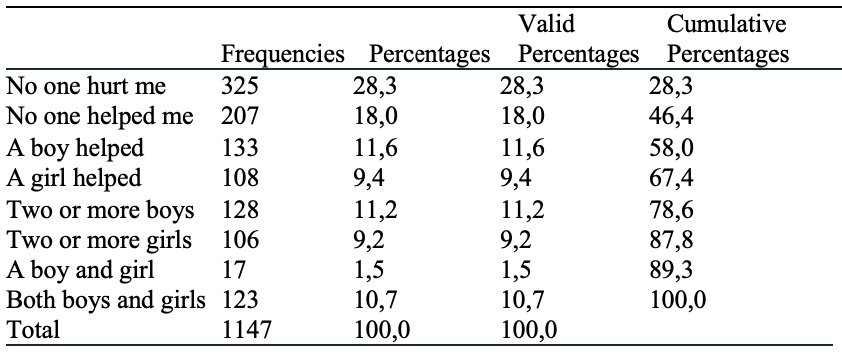
“Are there boys or girls who defended you when others tried to hurt